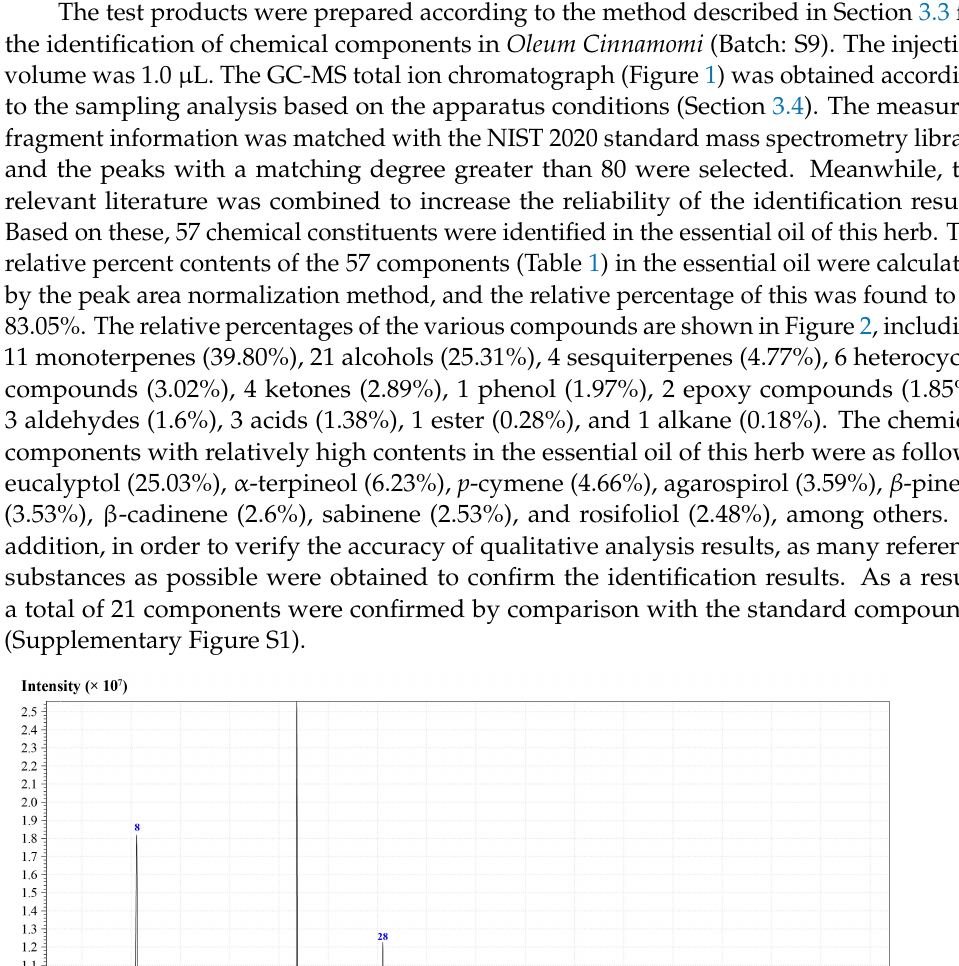
Figure 2. Relative percent contents of various compounds in Oleum Cinnamomi .